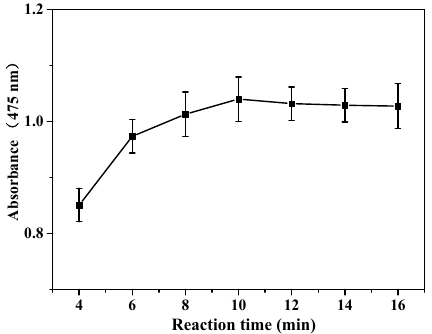
Figure 7. Effect of reaction time with 80 µ L SiW 9 Co 3 , 120 µ L DA, and 60 µ L H 2 O 2 . The concentration of DA could be detected by SiW 9 Co 3 under the optimum reaction condition.